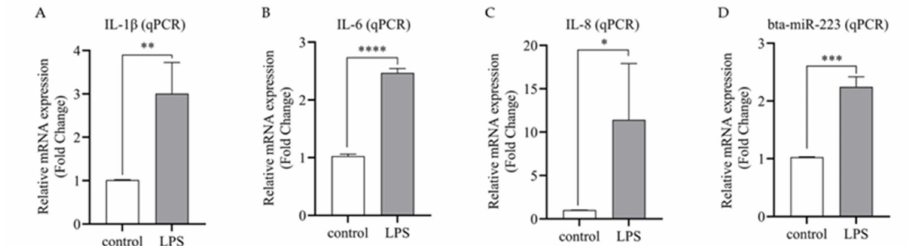
Figure 3. Establishment of inflammatory cell model and bta-miR-223 expression assay. ( A,B,C ) Ex- pression of three inflammatory factors (IL-1 β , IL-6 and IL-8) were significantly up-regulated in LPS-stimulated bMECs, indicating successful inflammatory cell model establishment. ( D ) Bta-miR- 223 expression was significantly up-regulated in LPS-induced inflammation. The qPCR technique was used to detect the expression of each gene. The experimental results are displayed as the mean ± SEM. * p < 0.05, ** p < 0.01, *** p < 0.001, **** p <